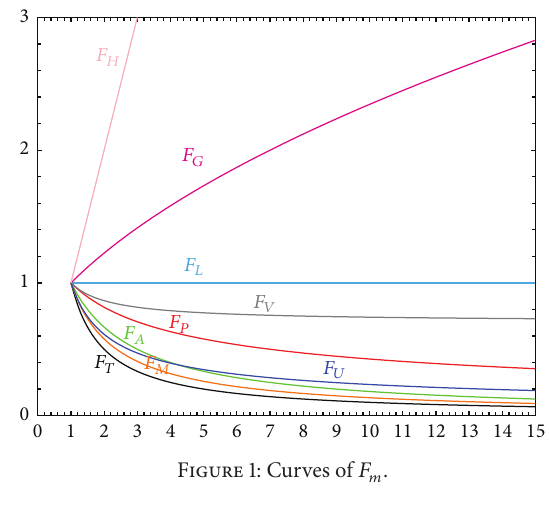
Figure 1: Curves of 𝐹 𝑚